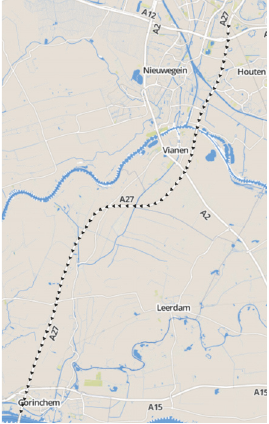
Figure 4: A27 test route, running from Utrecht (north) to Gor- inchem (south), covering 37 km.